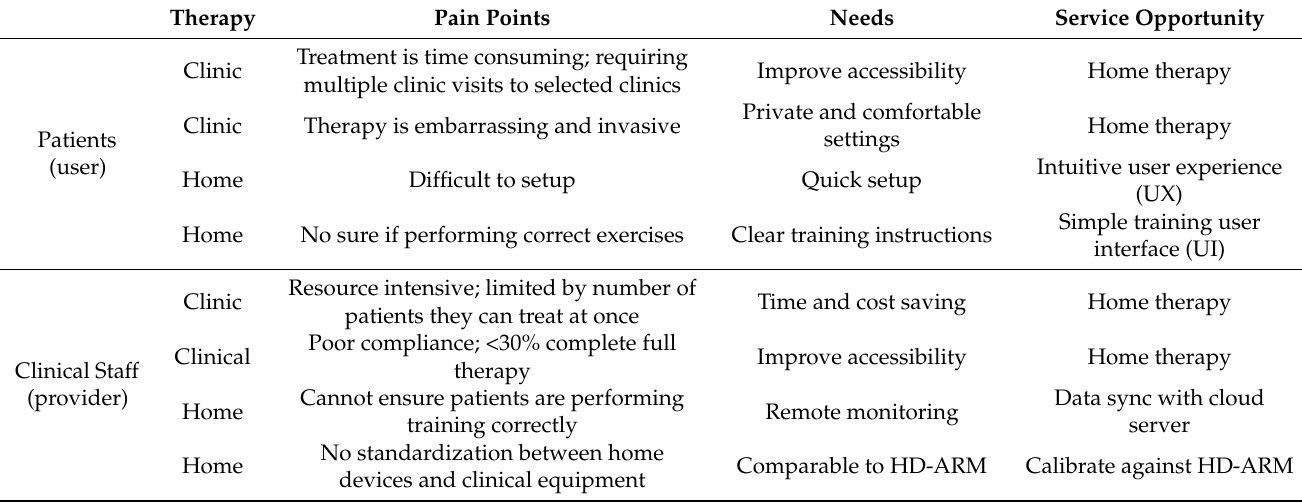
Table 2. Anorectal biofeedback needs of the patients and clinical